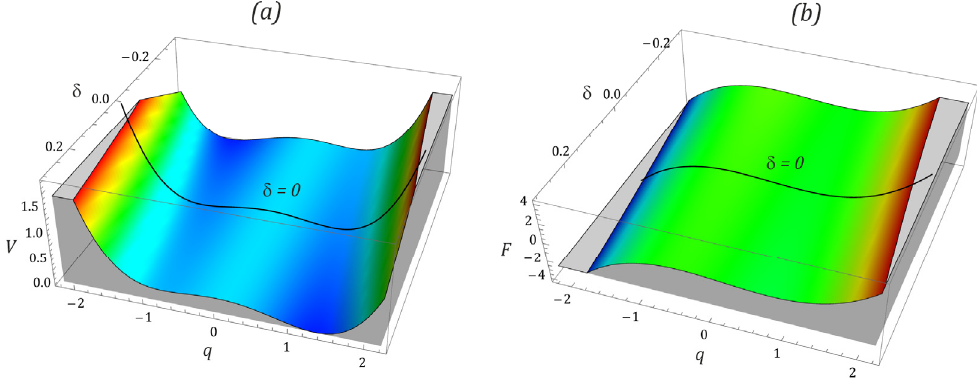
Figure 3. Three-dimensional visualization of the relationship between parameter δ ~ d 2 (see the dimensionless equation in Equations (11) and (12)) and: ( a ) Potential wells and barrier, ( b ) Mechanical characteristics (restoring force).